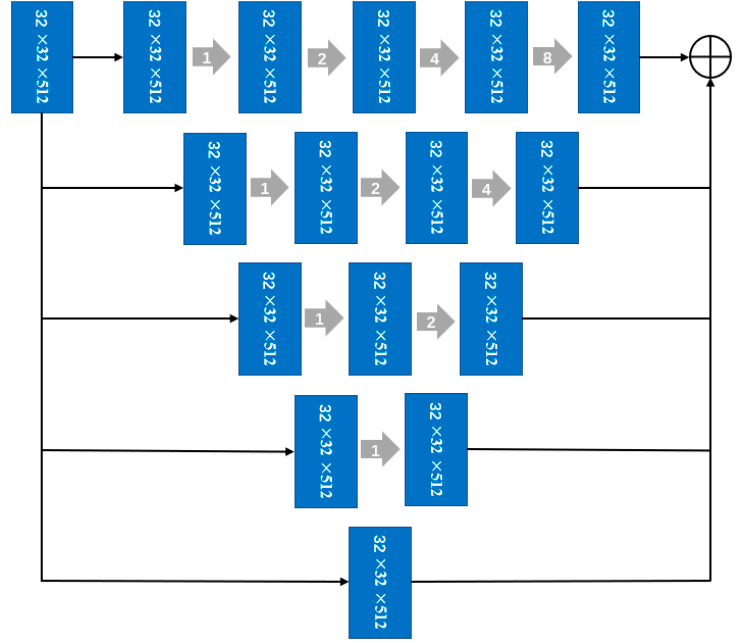
Figure 5. Structure diagram of multiparallel dilated convolution [28].